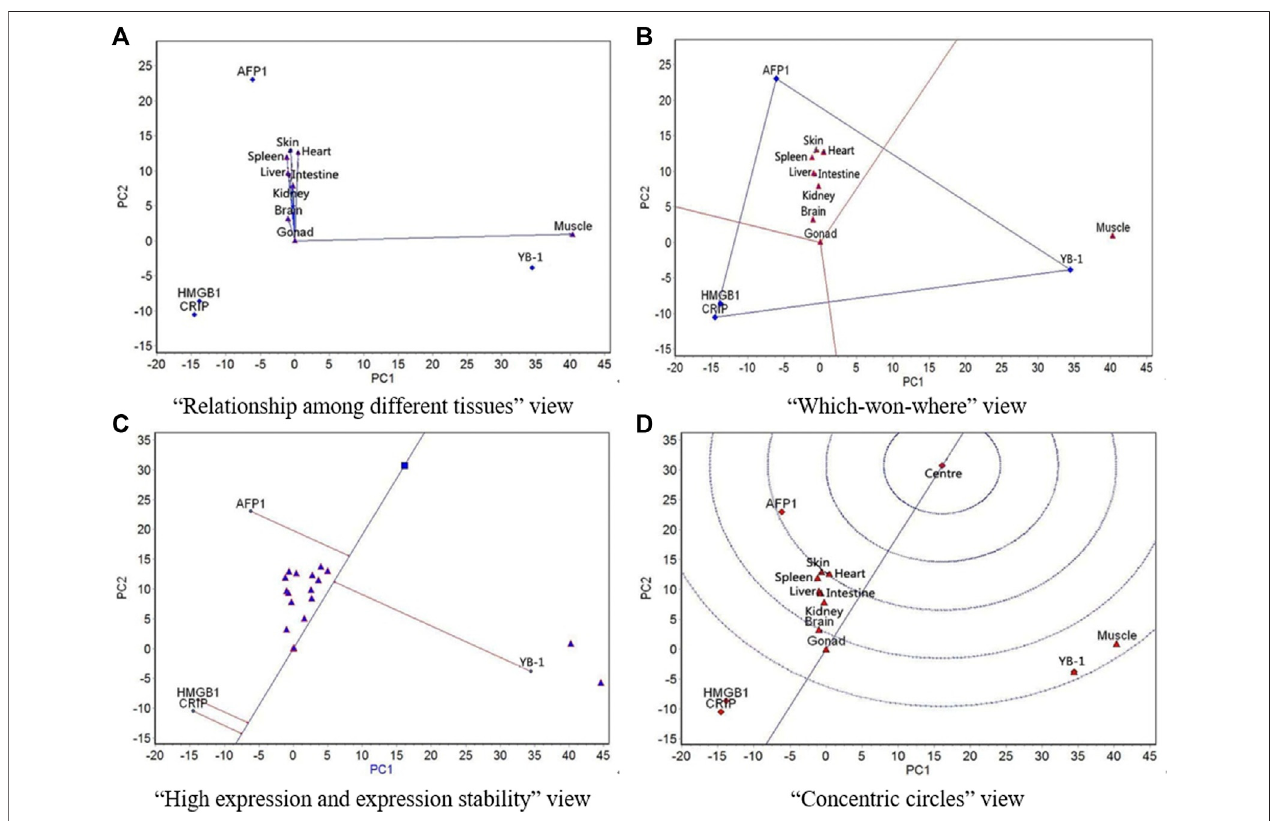
FIGURE 4 | The GGE biplot for expression of four resistance genes to low temperature (AFP1, CIRP, YB-1, and HMGB1) in different tissues at 13 ° C. (A) “ Relationship among different tissues ” view. (B) “ Which-won-where ” view. (C) “ High expression and expression stability ” view. (D) “ Concentric circles ”